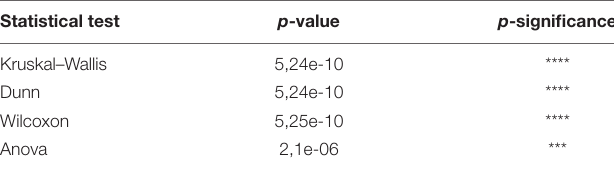
TABLE 1 | Statistical analysis of the comparison of (cid:49) rbcL growth in the presence and absence of acetate and its influence on central C metabolism. Different statistical analysis (Kruskal, Dunn, Wilcox, aov) show that 23 key metabolites are significantly affected by the presence of acetate. Statistical test p